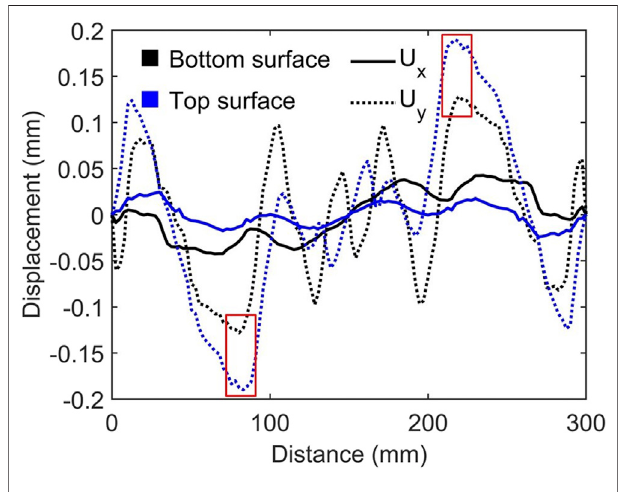
FIGURE 11 | The displacements along the x- and y-centerlines of the 0.22/0.36 [0 ° /0 ° ]/0.22 plate under the impulsive load of Z (cid:2) 1 . 46 m / kg 1 / 3 .